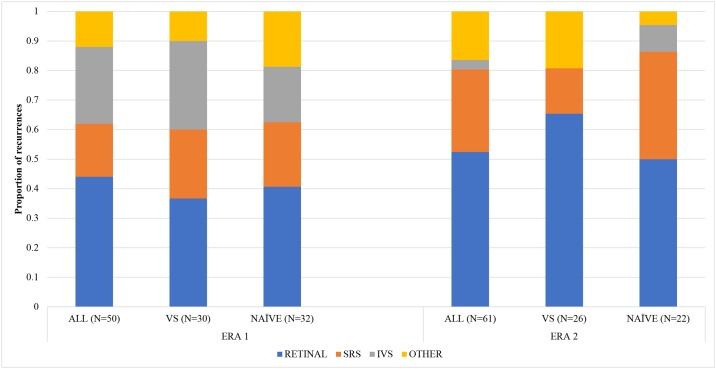
Recurrences by type.